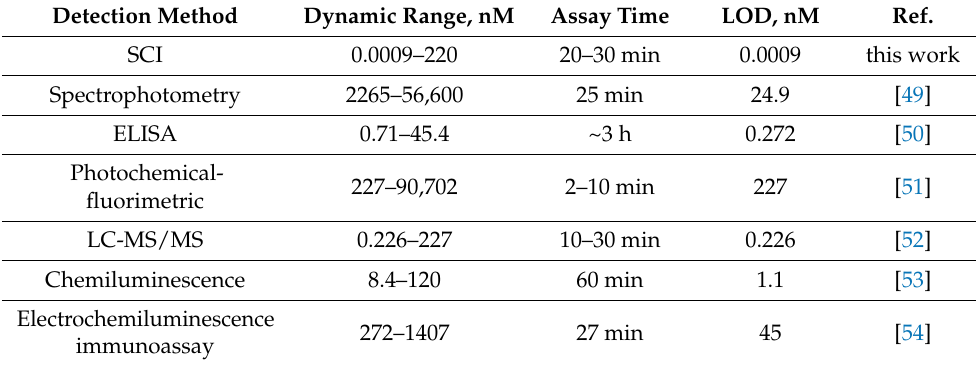
Table 1. Comparison of different methods for FA